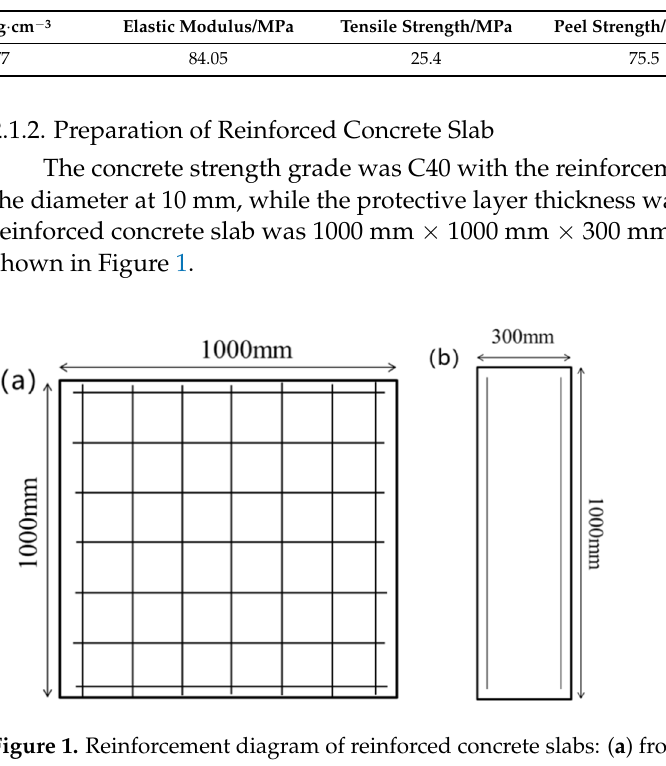
Table 1. Physical properties of t26 polyurea.